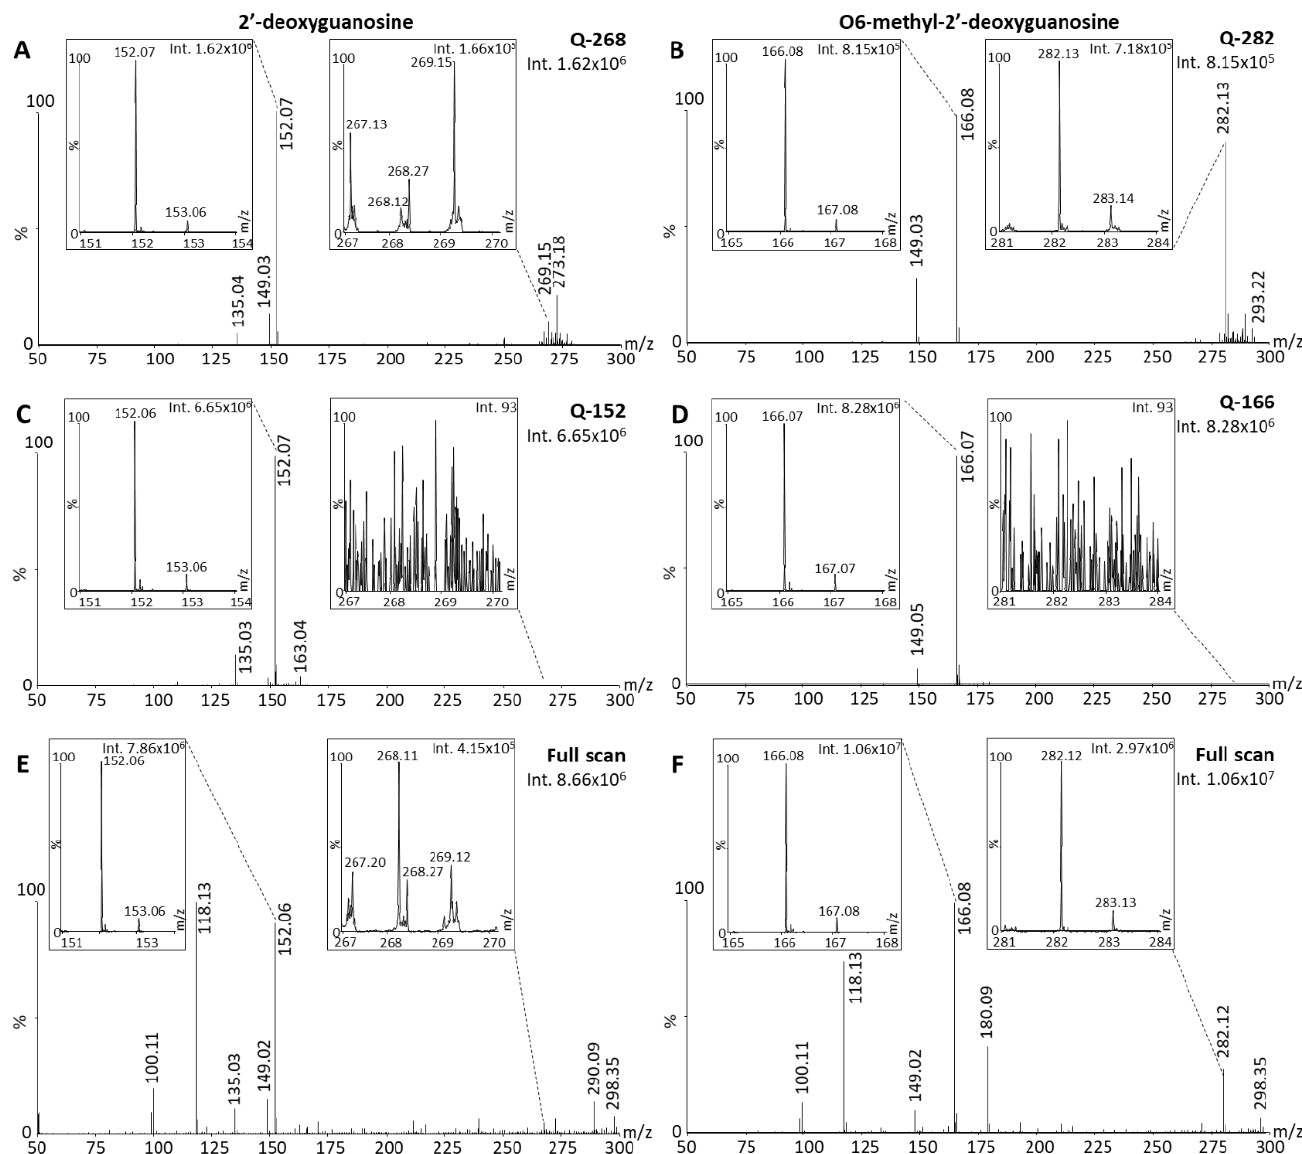
Figure 5. Desorption electrospray ionization (DESI) mass spectra of 2′ -deoxyguanosine (2dGO) and O6-methyl- 2′ -deoxyguanosine (O6-m2dGO) stock solutions at 0.5 µg/mL in MeOH/H 2 O 1:1 with zoomed views on the parent peaks (m/z 268.11 and m/z 282.12, respectively) and the main post-source decay (PSD) fragment peaks (m/z 152.06 and m/z 166.08, respectively). Spectra were acquired with the quadrupole focused on the parent mass without collision energy; methods Q-268 for 2dGO ( A ) and Q-282 for O6-m2dGO ( B ), with the quadrupole focused on the PSD fragment mass without collision energy; methods Q-152 for 2dGO ( C ) and Q-166 for O6-m2dGO ( D ), or in full scan for both 2dGO ( E ) and O6-m2dGO ( F ). Maximum intensities are given in arbitrary units (a.u.) on the top right corner of each spectrum and zoomed view.